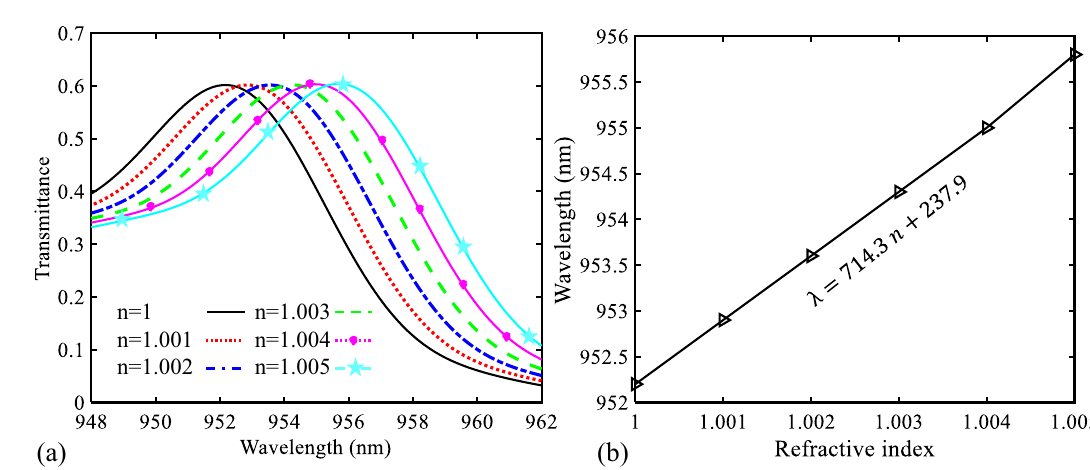
Figure 14. ( a ) Transmission spectra of the proposed biosensor II for refractive index changes from 1 to 1.005 in steps of 0.001. ( b ) Relationship between the wavelength of the PBG’s low edge and different values of the refractive